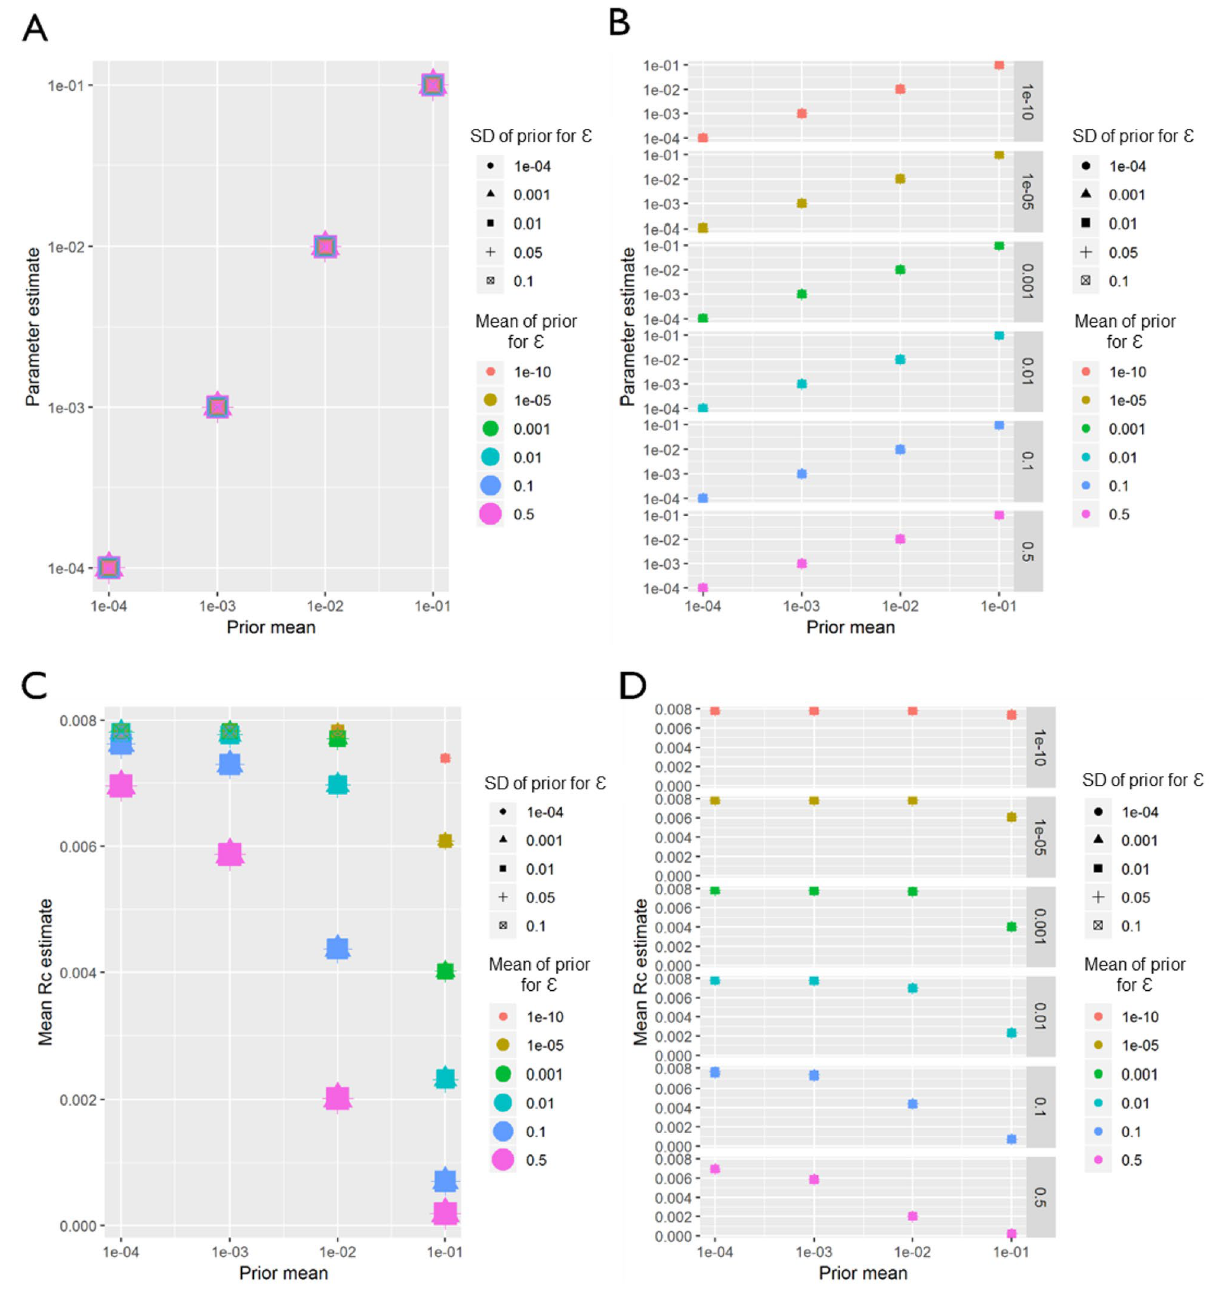
Figure 11. China ( P. falciparum ) Sensitivity Analysis. Sensitivity analysis showing the impact of varying the prior means for P. falciparum in China. Sensitivity analysis showing the impact of varying the prior means for Eswatini. Sensitivity analysis showing the impact of varying the prior mean for the distance kernel shaping parameter, β. The different colours and shapes represent different means and standard deviations respectively of the normally-distributed prior of epsilon, ε, which represents shapes represent different hazards of infection by an external, unobserved source. For ( A )–( D ), the x-axis represents the prior mean used for β. ( A ) the y-axis shows the maximum a posteriori parameter estimate for the parameter β. ( B ) shows the same results, stratified by the prior mean of ε for clarity. ( C ) Shows the impact of priors for β and ε on the mean Rc estimate, and again ( D ) shows the same result, stratified by the prior mean of